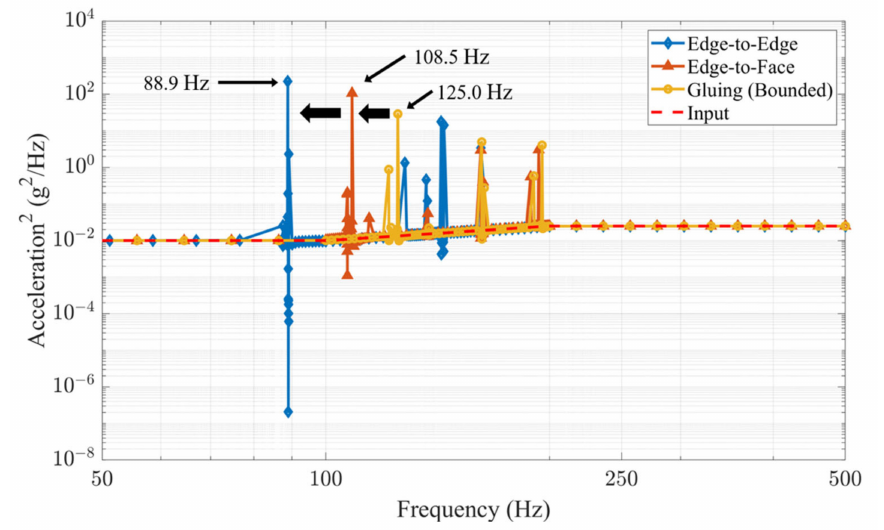
Figure 20. 1st mode natural frequency shifts as constraint level